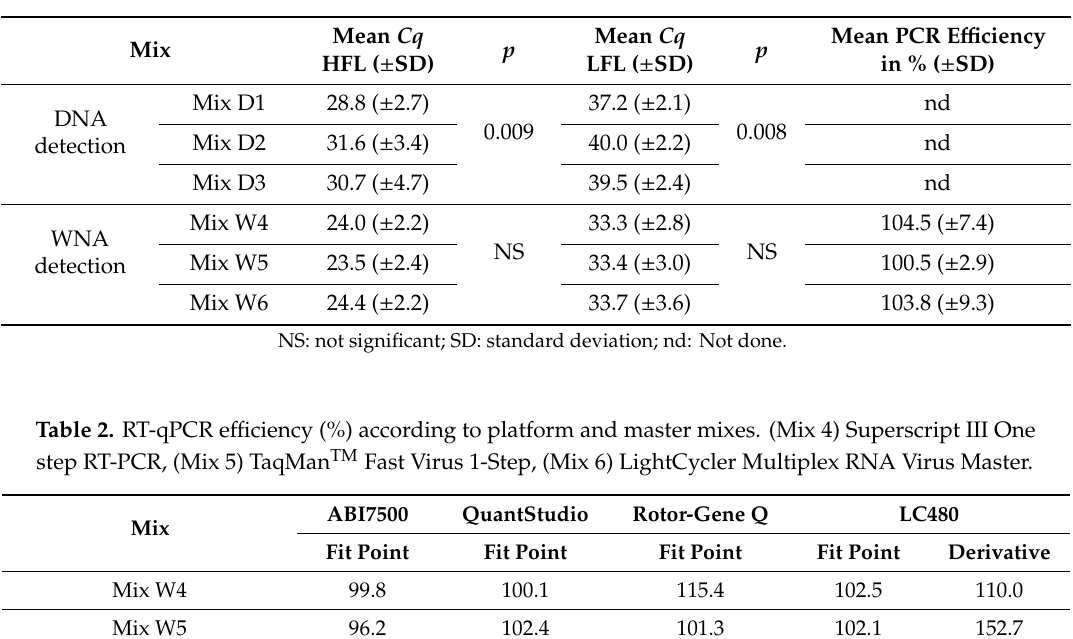
Table 1. Analysis of mixes’ performance independently of qPCR equipment. Mean e ffi ciency of PCR reaction could not be calculated for the DNA method as Cq ranges were too low. HFL: high fungal load (pure extract); LFL: low fungal load (1:1000); Cq : quantitative cycle. (D1) LightCycler 480 Probes